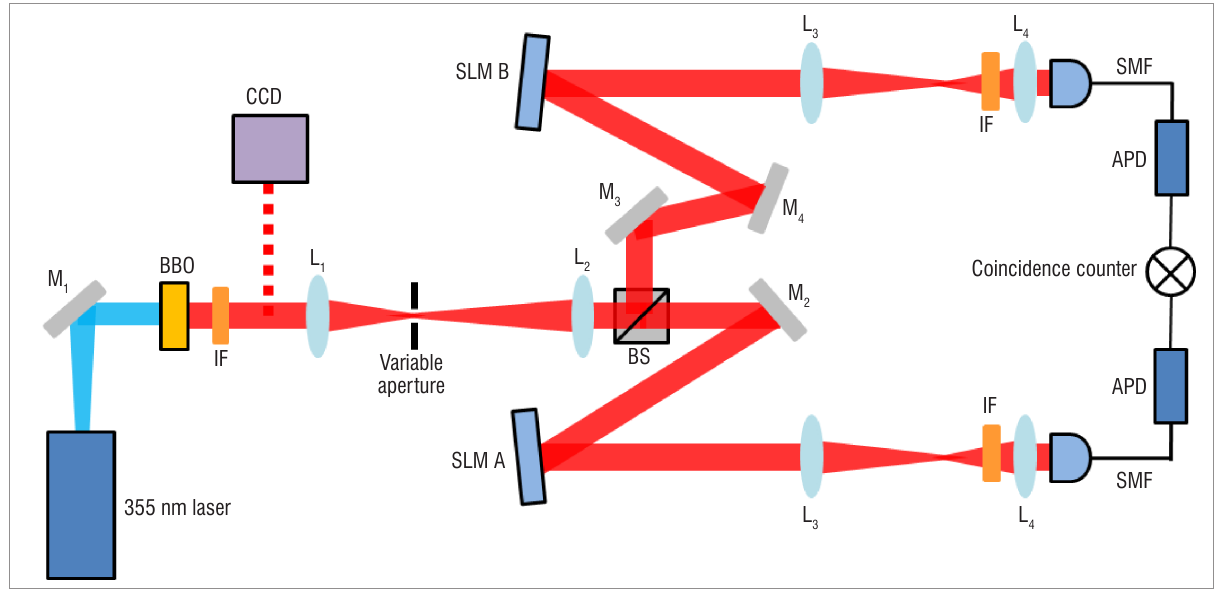
Figure 2: Experimental set-up used to detect the orbital angular momentum eigenstates after spontaneous parametric down-conversion. The plane of the crystal was relay imaged onto two separate spatial light modulators (SLMs) using lenses L Laguerre–Gaussian modes were selected. Lenses L nm bandwidth interference filters (IF) to the inputs of the single-mode fibres (SMFs). Each SMF was connected to an avalanche photodiode (APD) single photon detector, which in turn was connected to a coincidence